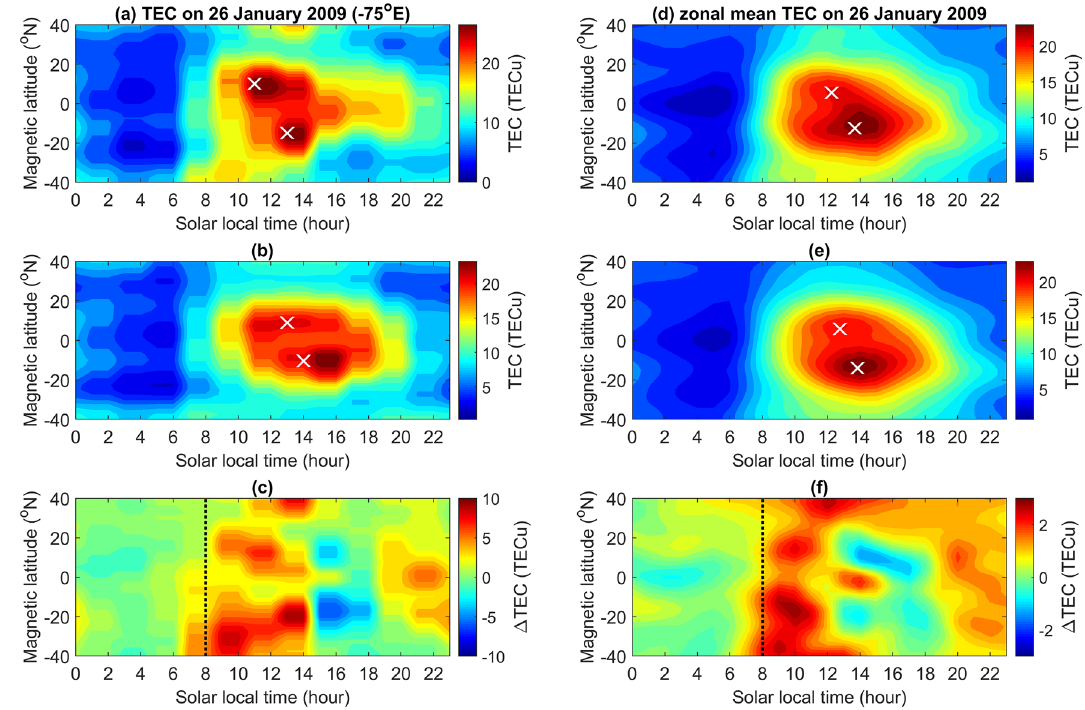
Figure 1. LTT plots of the GIM TEC and their associated differences along − 75° E longitude and the zonal mean on 26 January 2009. LTT along − 75° E longitude on ( a ) 26 January 2009, ( b ) associated median of 7 days before and after, and ( c ) their difference, respectively. ( d–f ) zonal mean LTT of 24 longitudes of the globe on 26 January 2009, reference, and their difference, respectively. White cross symbols denote the corresponding EIA crests in Northern and Southern Hemispheres. Dashed black lines denote 08:00 SLT. Note that the EIA crest of the reference is computed by averaging over the individual crest 7 days before and after 26 January 2009. The TEC unit (TECu) is 10 16 #/m 2